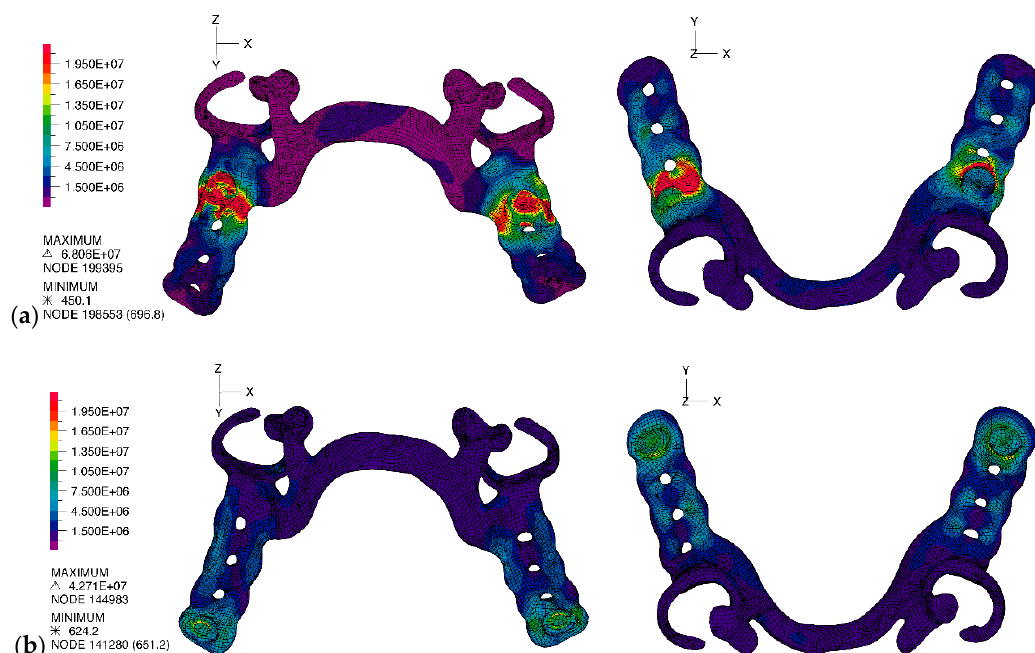
Figure 6. Smoothed von Mises stress distribution: ( a ) IARPD PM model, bottom view on the left, top view on the right; ( b ) IARPD MO model, bottom view on the left, top view on the right.